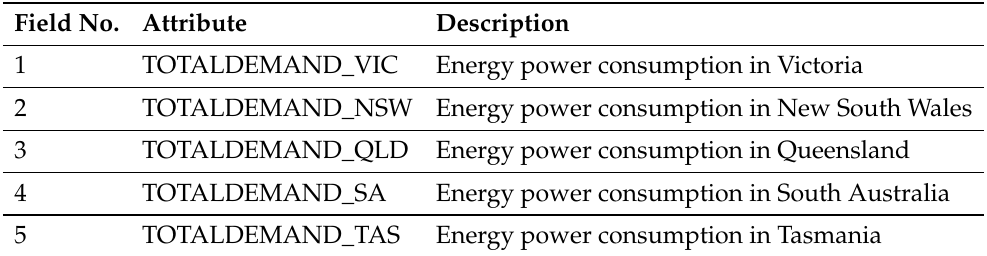
Table 3. Dataset Attributes.